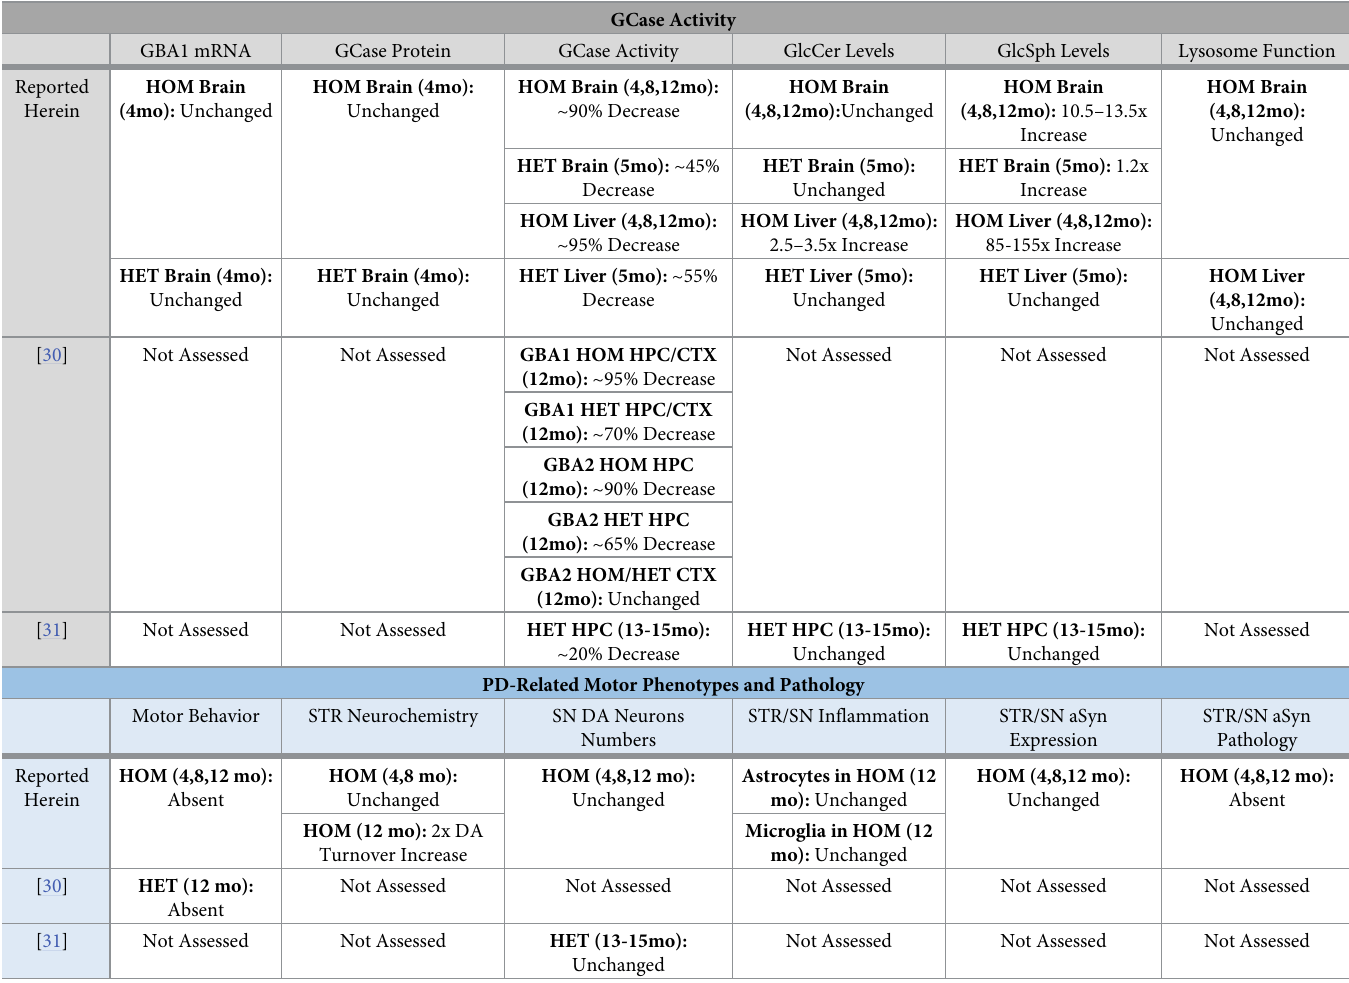
Table 1. Characterization summary the GBA1 D409V KI mouse (JAX Strain